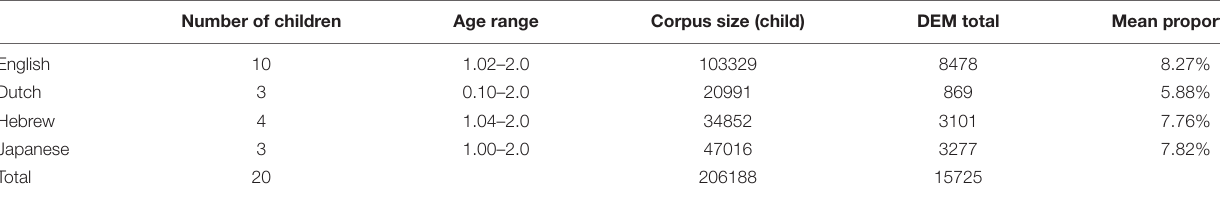
TABLE 2 | Raw frequencies and mean proportions of demonstratives in early child speech. Number of children Age range Corpus size